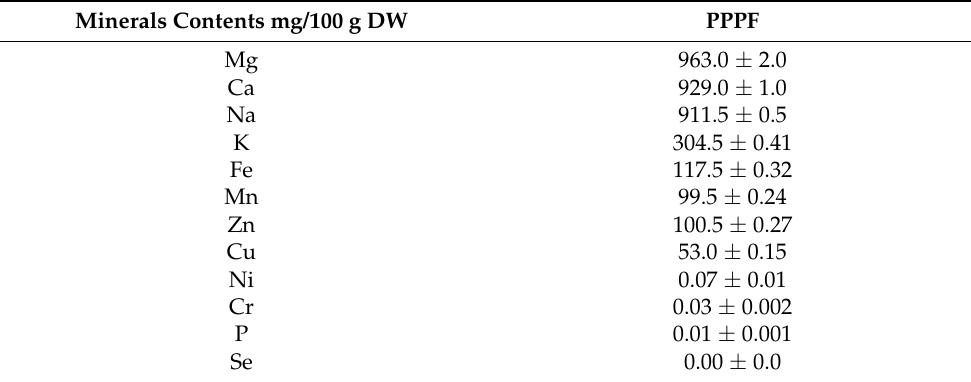
Table 4. The minerals content of prickly pear peel